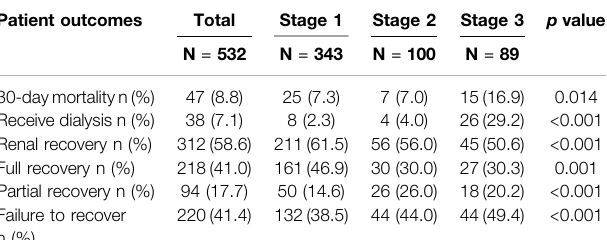
TABLE 5 | Outcomes of VA-AKI